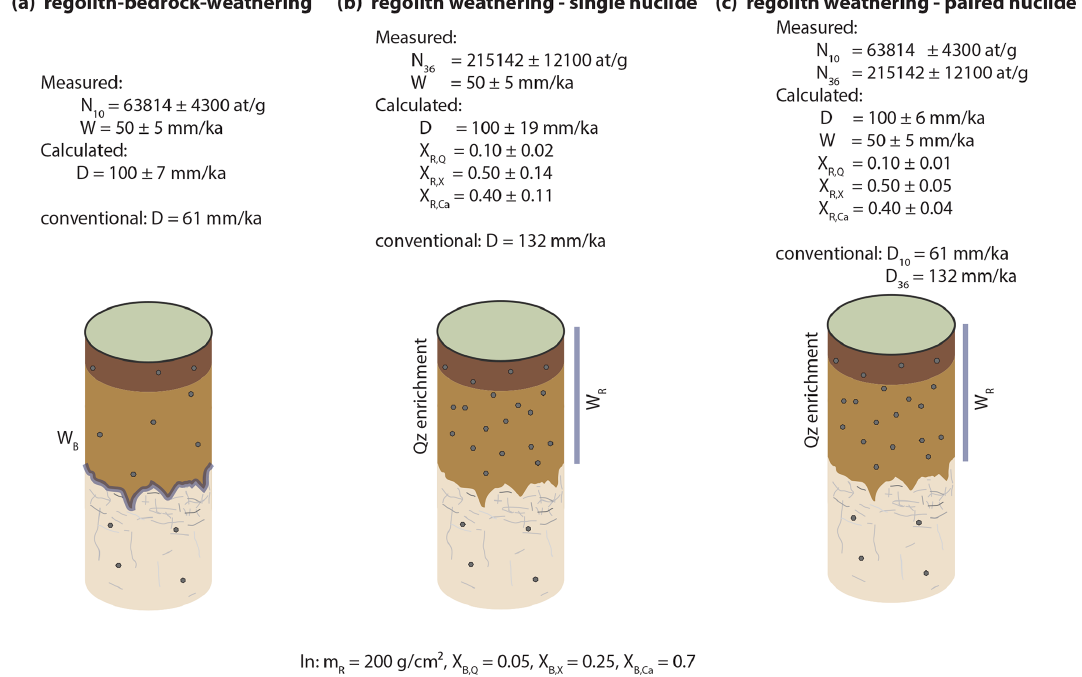
Figure 6. Calculation of “true” denudation rates for our test data. (a) Correction for weathering along the regolith–bedrock interface for a 10 Be measurement on quartz (could also be applied to 36 Cl on calcite). The conventional denudation rate refers to a rate calculated without weathering correction. (b) Correction for a single-nuclide measurement and regolith weathering. In this case the weathering rate, e.g. from stream chemistry, needs to be known. (c) Calculation of denudation and weathering rate from a paired-nuclide measurement, where one target mineral is insoluble and one is soluble. In this case we show the data for a combined measurement of 36 Cl on calcite and 10 Be on